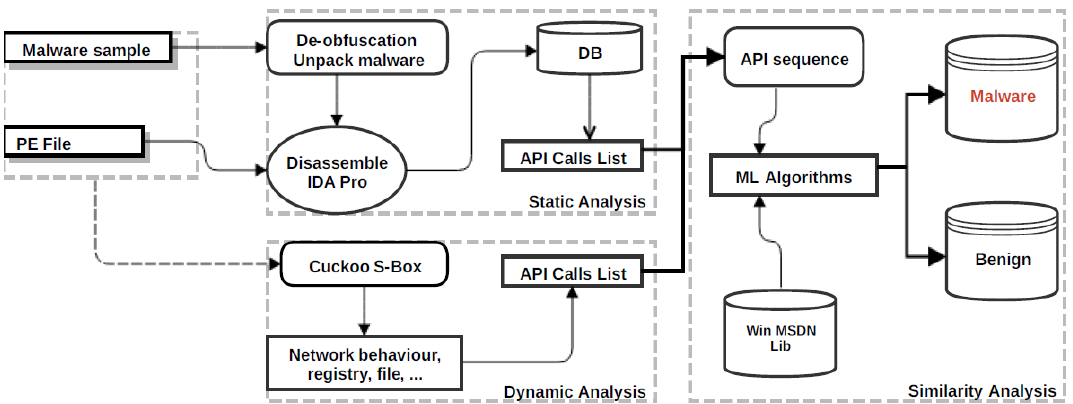
Figure 1. Framework for the analysis and classification of malware. API: definition. 154